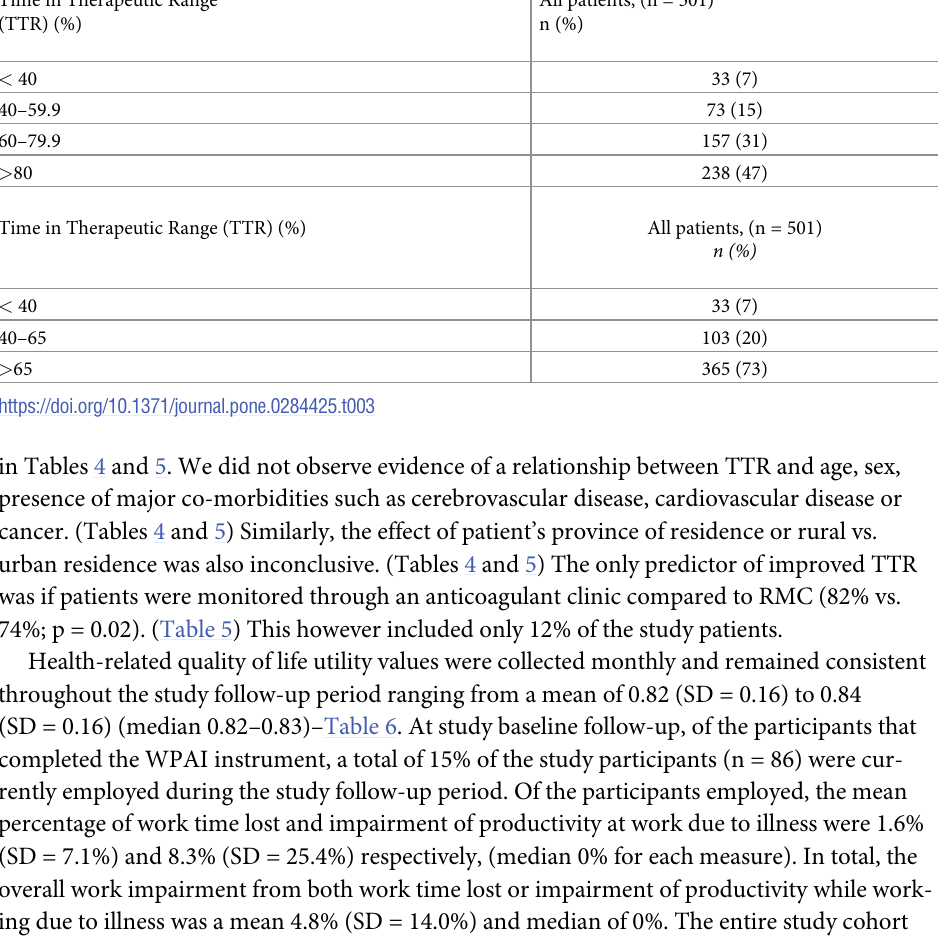
Table 3. a. Distribution of TTR based on poor, sub-optimal, good and excellent control. b. Distribution of TTR based on poor, fair and good control. Time in Therapeutic Range (TTR)